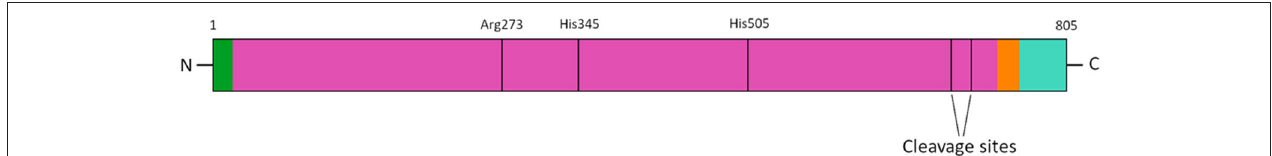
FIGURE 4 | ACE2 protein schematic. An annotated schematic of the primary structure of ACE2. Arg273 is essential for substrate binding, by facilitating the formation of a salt-bridge. His345 and His505 assist with stabilising the substrates transition state during catalysis (118). The cleavage sites for the in vivo production of sACE2 are Arg697 and